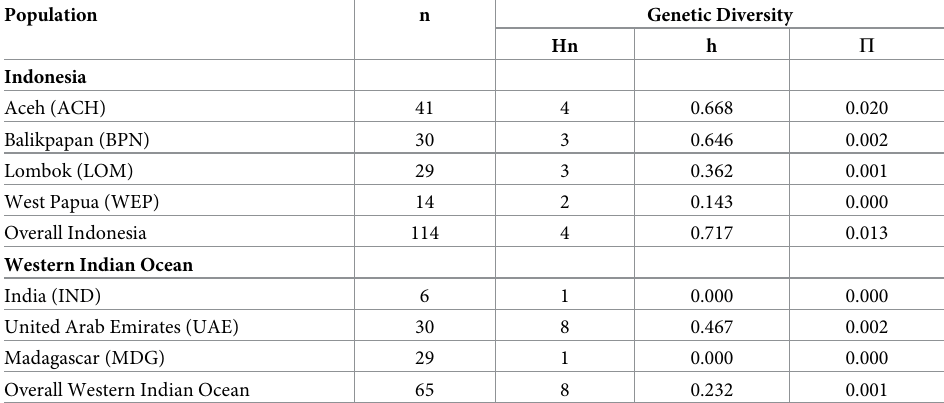
Table 4. Genetic diversity of S . lewini based on sample size (n), haplotype number (Hn), haplotype diversity (h), and nucleotide diversity ( π ) in samples from each site in Indonesia and the Western Indian Ocean region. Population n Genetic Diversity